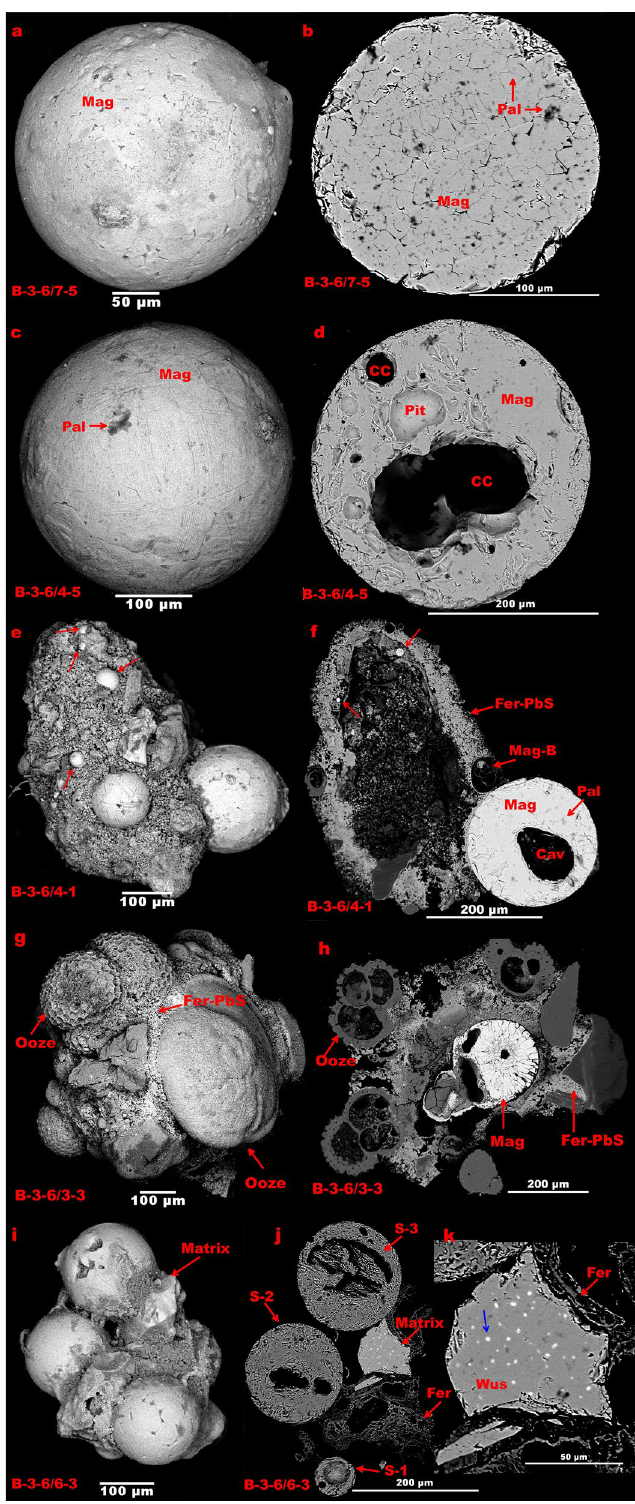
Figure 2. Spherules from the Central Indian Ridge. ( a , c , e , g , i ) Showing the external surface of the spherules. ( b , d , f , h , j , k ) Showing the polished section. Here, Wus—wustite, Mag—Magnetite, Pal—Palagonite, CC— Cylindrical cavity,